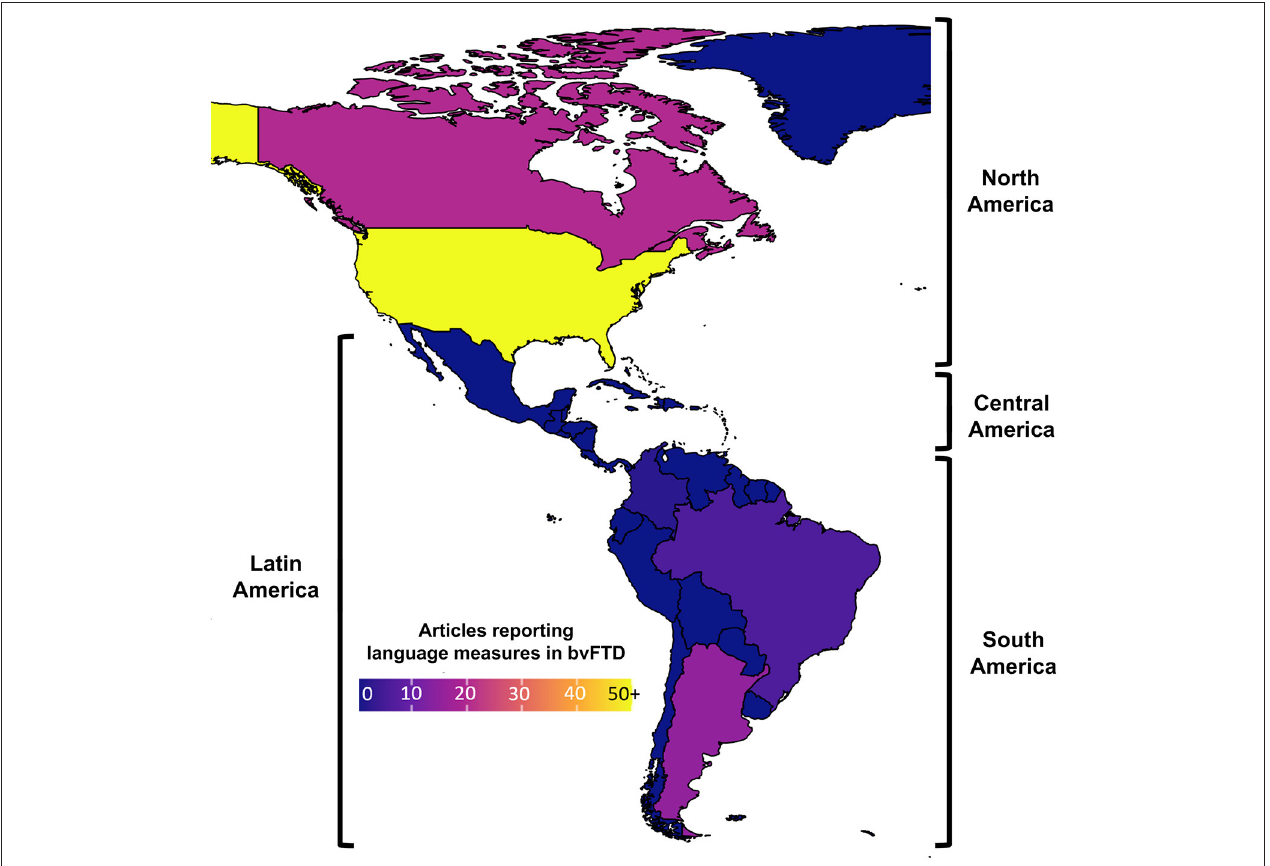
FIGURE 1 | Articles reporting language measures in behavioral variant frontotemporal dementia (bvFTD) cohorts. A systematic review (see Supplementary Material ) reveals that, unlike North America (where numerous bvFTD studies have reported language measures), Latin America has produced little evidence on the topic (ranging from low to null, depending on the